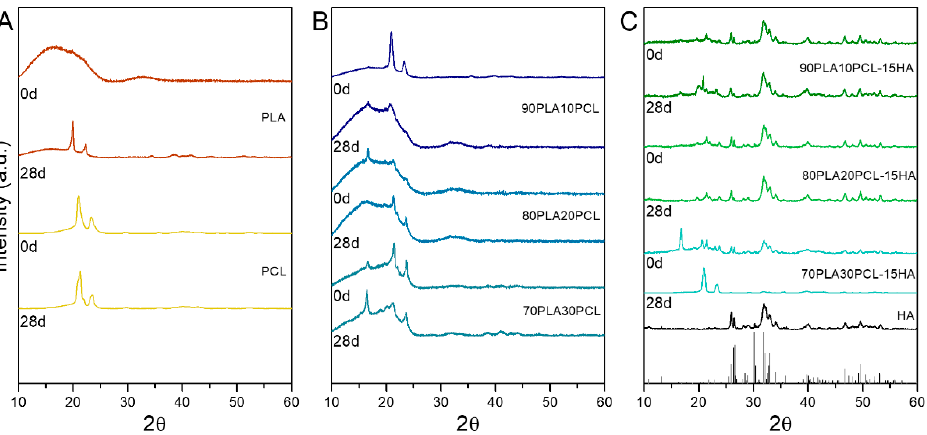
Figure 7. X-ray diffraction (XRD) data for neat samples (0 days) and after degradation (28 days); ( A ) pure polymers PLA and PCL, before and after degradation; ( B ) PLA/PCL blends before and after degradation; and ( C ) composite blends before and after degradation.